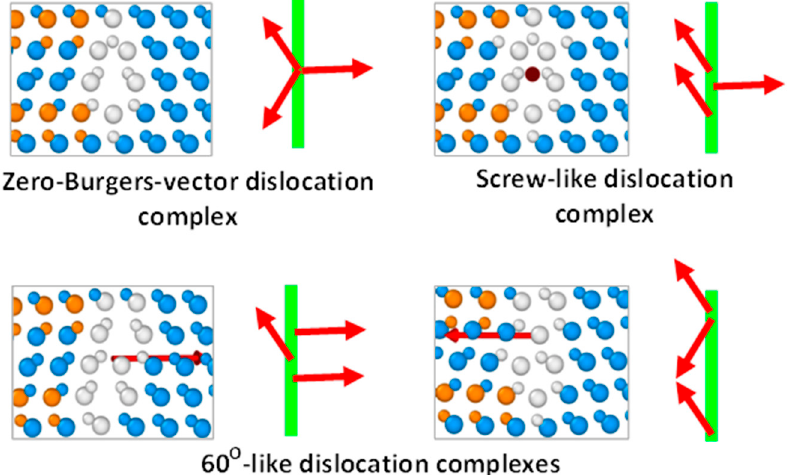
Figure 5. Examples of the atomic configurations of triple PD complexes in 3C-SiC viewed in the [110] direction together with schematic representations of dislocation Burgers vectors with respect to the dislocation lines viewed perpendicular to the [ 111 ] plane. Zero-Burgers-vector complex is stable, while other complexes experience dissociation into double PD complex and single partial dislocation during annealing. Arrows indicate the directions of the Burgers vectors of the complexes as well as complex composing partial dislocations. Vertical lines correspond to the dislocation lines.